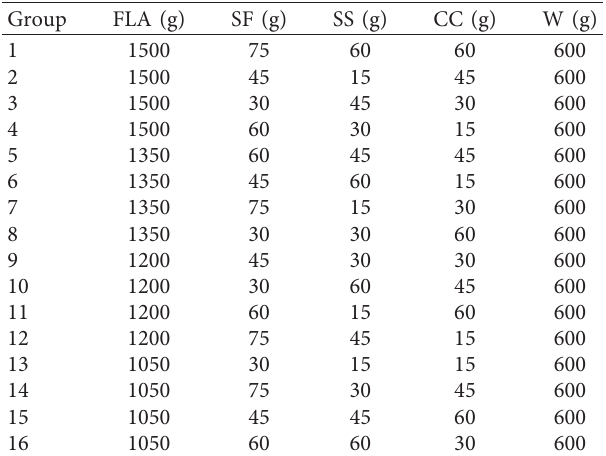
Table 2: Orthogonal test ratio table of green fly ash-based grouting material.